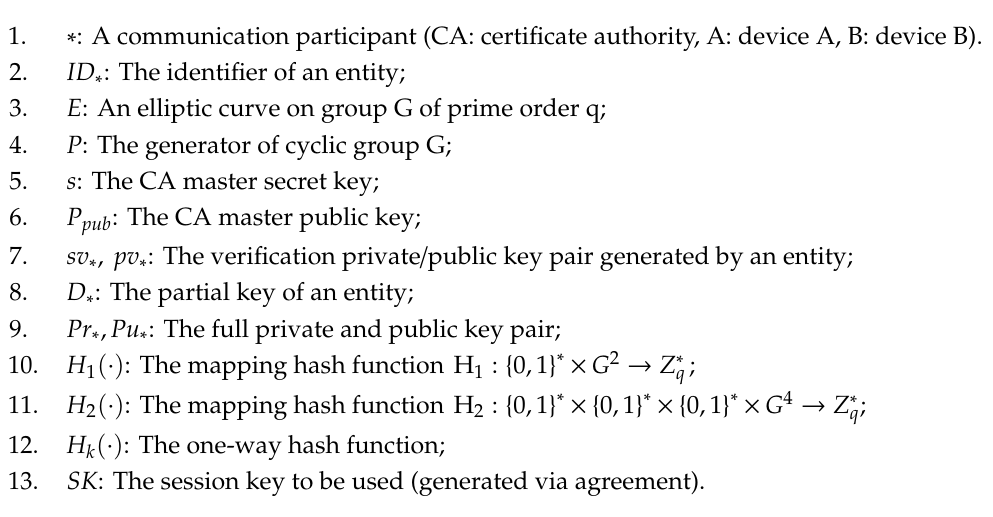
Figure 6. The scenario of Scheme 2.